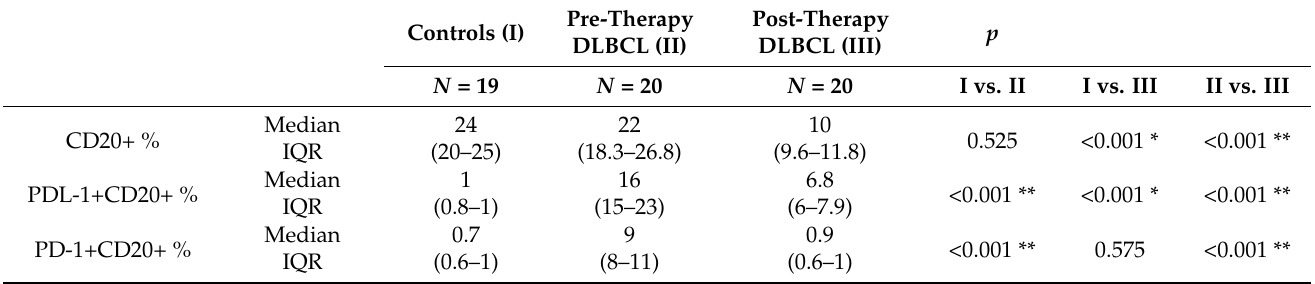
Table 3. CD20+ %, PD-L1+CD20+ %, and PD-1+CD20+ % in DLBCL patients and healthy subjects.